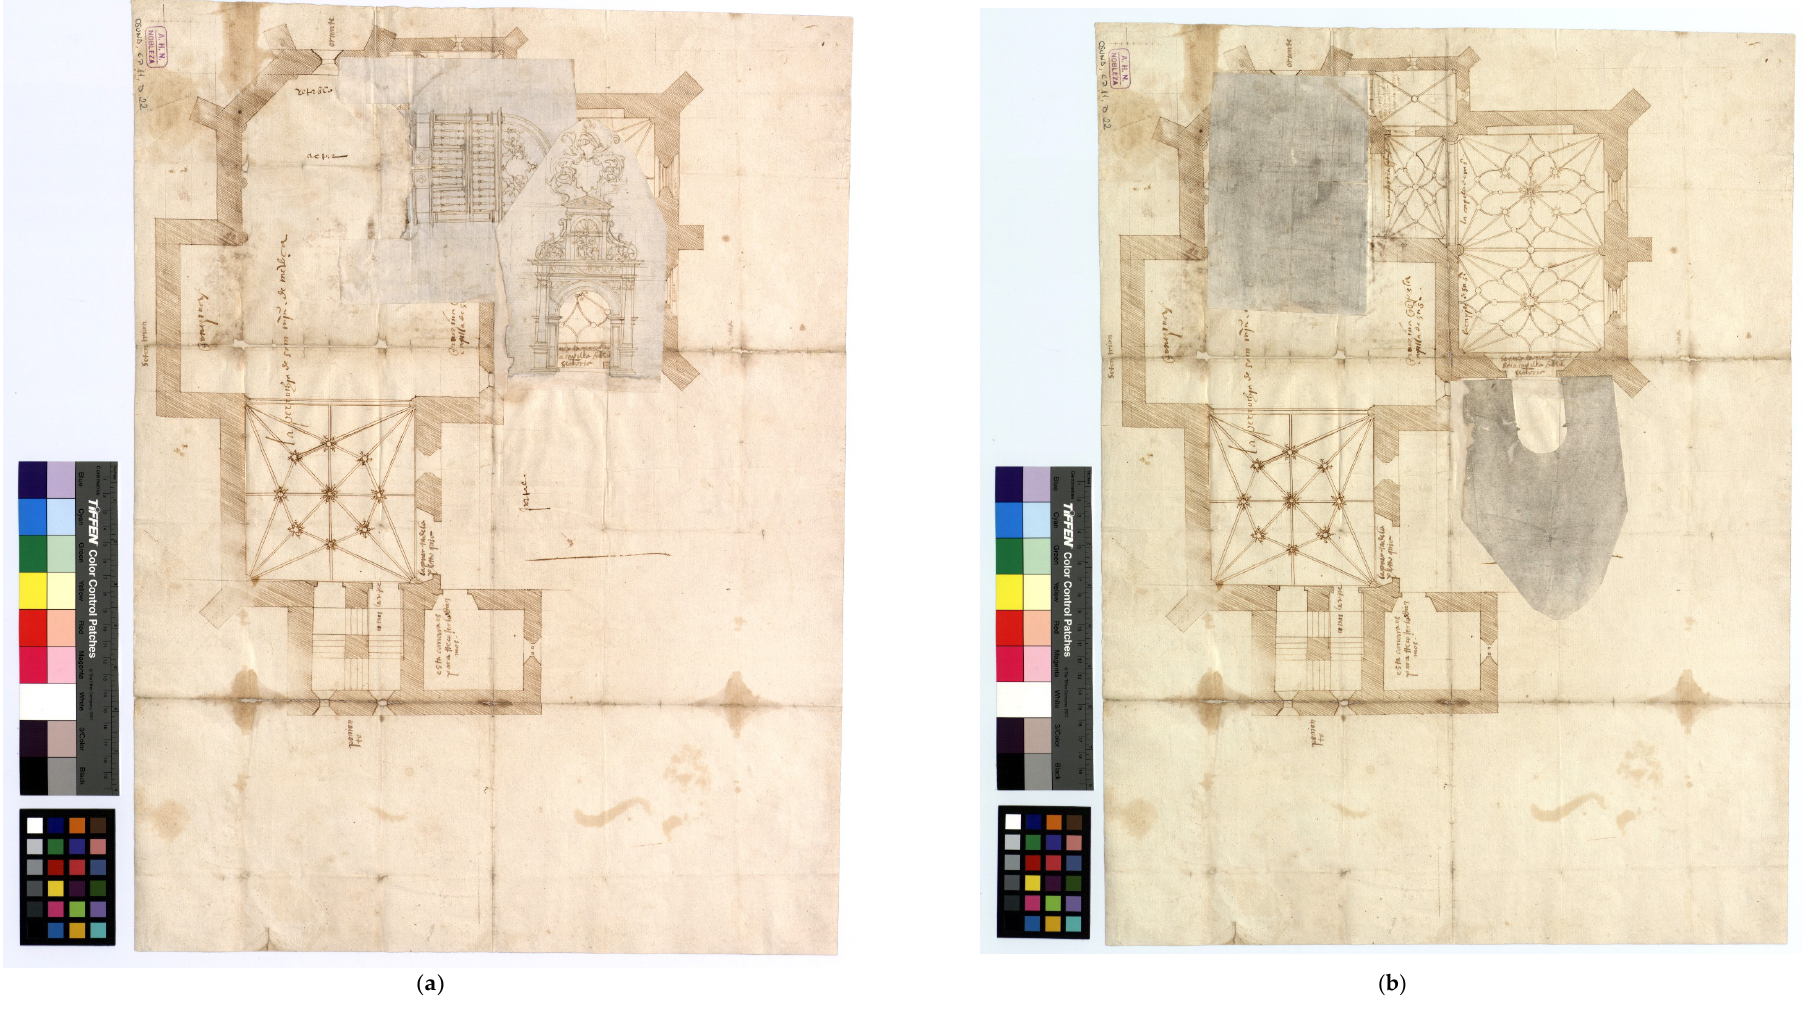
Figure 6. ( a , b ) Project for the chapel of the Dukes of Infantado in the church of San Martín de Mendoza (Álava), with the “folding tabs” opened and closed [Archivo Histórico de la Nobleza (A.H.NO.), OSUNA, CP. 11, D. 22]. © Archivo Histórico de la Nobleza.